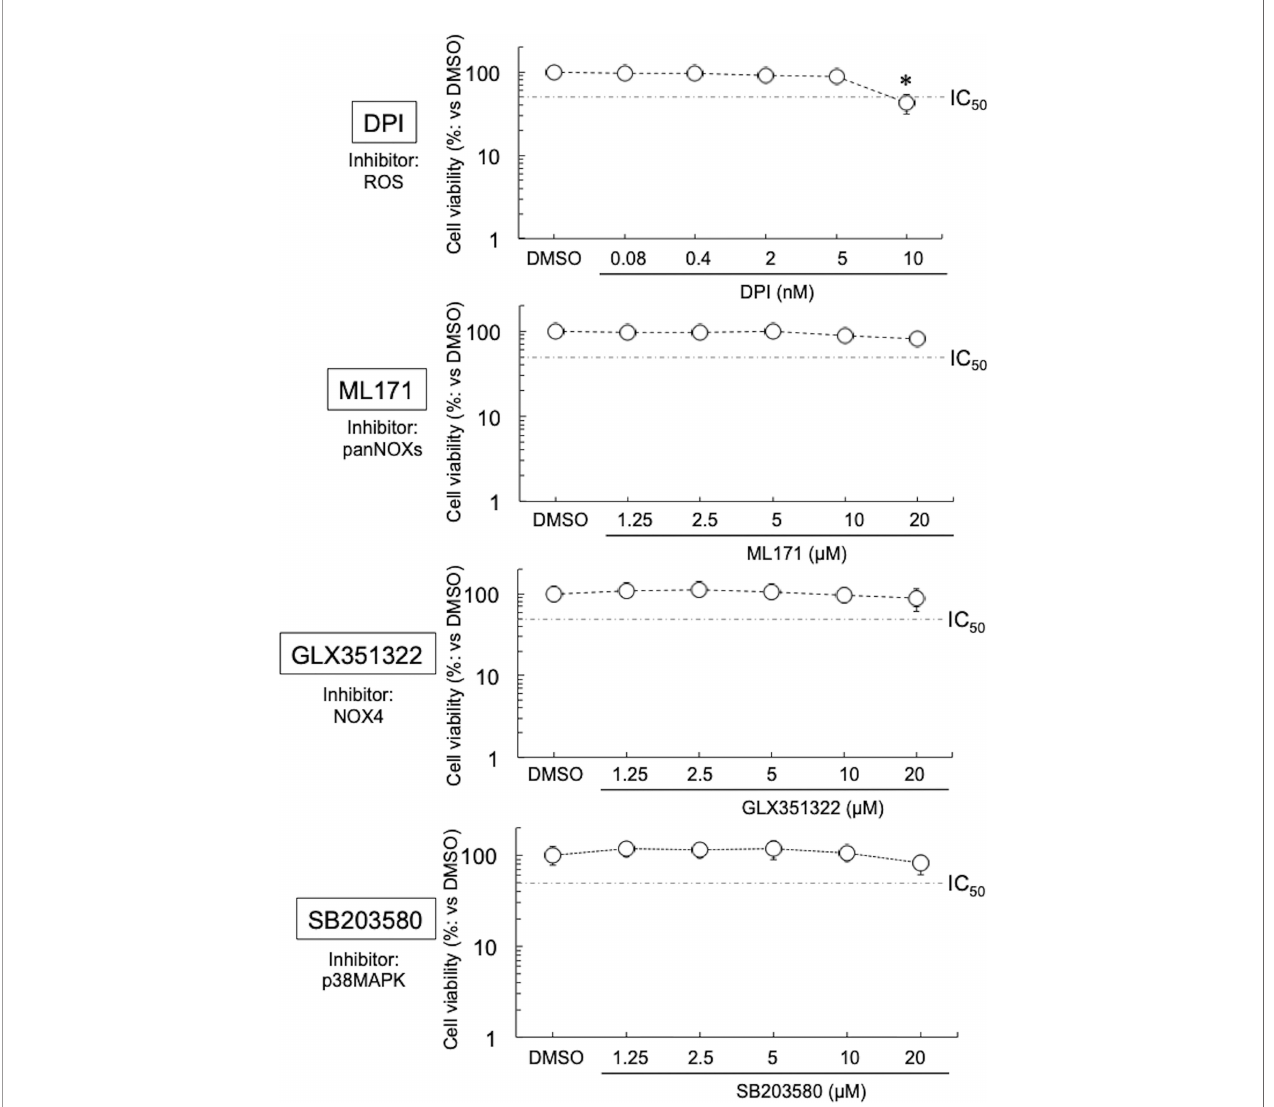
FIGURE 1 | Viability of HEp-2 cells in the presence of inhibitors (DPI, ML171, GLX351322, and SB203580). The cells were cultured with or without inhibitor for 24 h, and then the cell viabilities were assessed using Cell Counting Kit-8 (see Methods ). Data show means ± SD ( n = 6) as a relative value of the cell-only (dimethylsulfoxide-treated) viability (which is de fi ned as 100%). * p < 0.05 vs . dimethylsulfoxide-treated. Dotted lines show IC 50